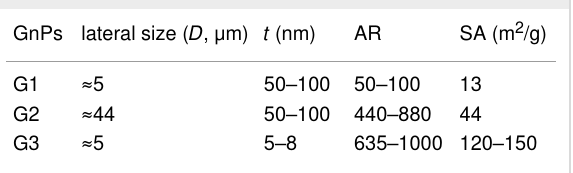
Table 4: Sizes of GnPs used in this